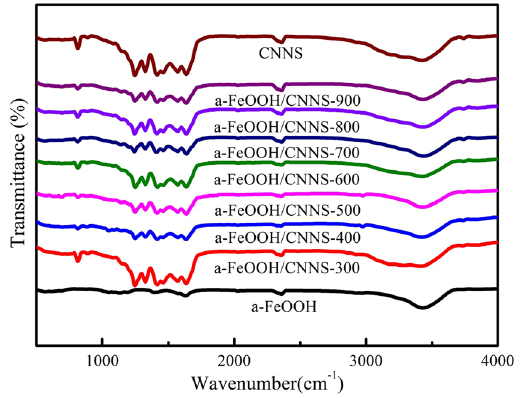
Figure 3. FT-IR spectra of CNNS, a-FeOOH and a-FeOOH/CNNS